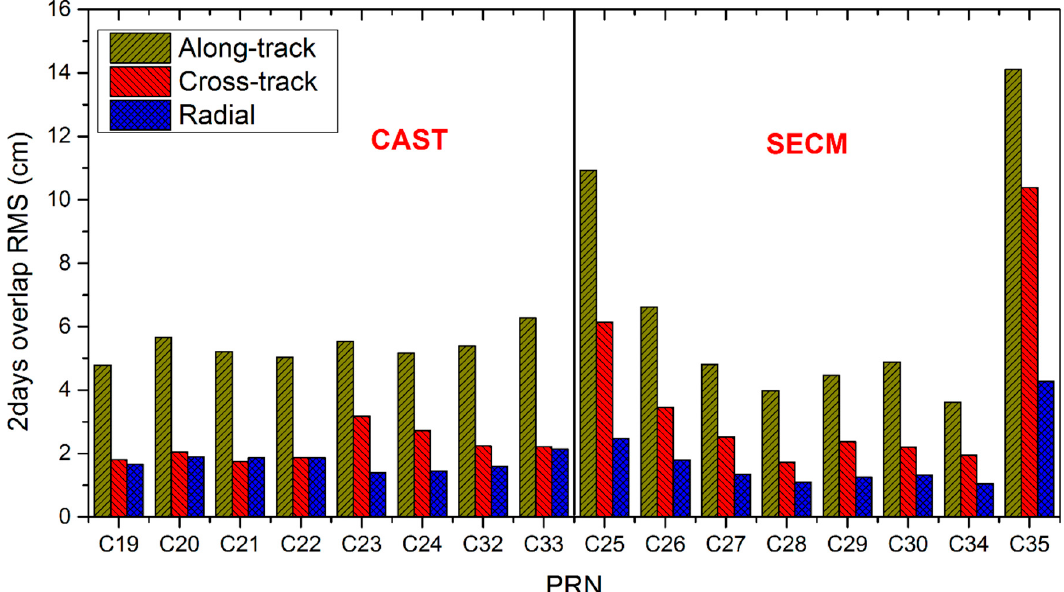
Figure 8. The RMS values of the BD3 MEO satellites’ two-day (2days) overlap comparison in the along-track, cross-track and radial directions. The left panel presents the results of the satellites made by CAST and the right panel is the results of satellites made by SECM.